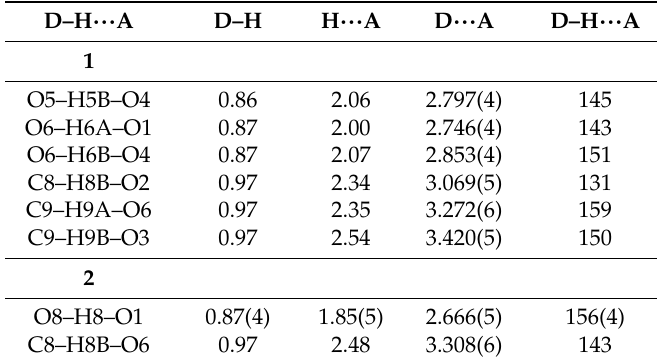
Table 3. Hydrogen bonding interactions (Å, ° ) for complexes 1 and 2 .